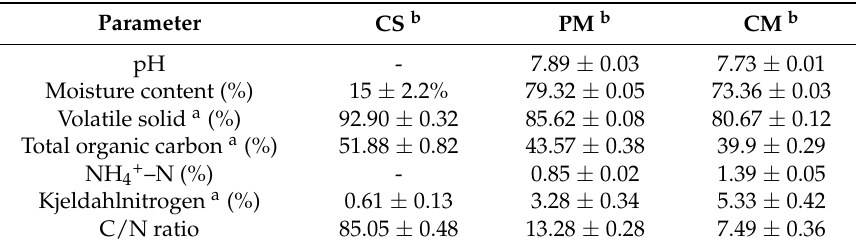
Table 2. Characteristics of CS, PM, and chicken manure (CM).